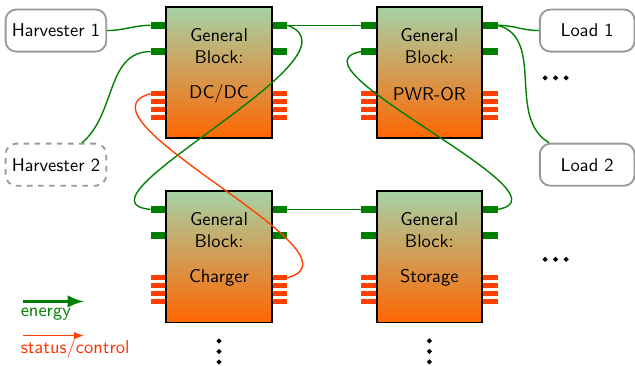
Figure 3. A homogeneous structure of a power management built up from general hardware blocks with fixed interface for energy and